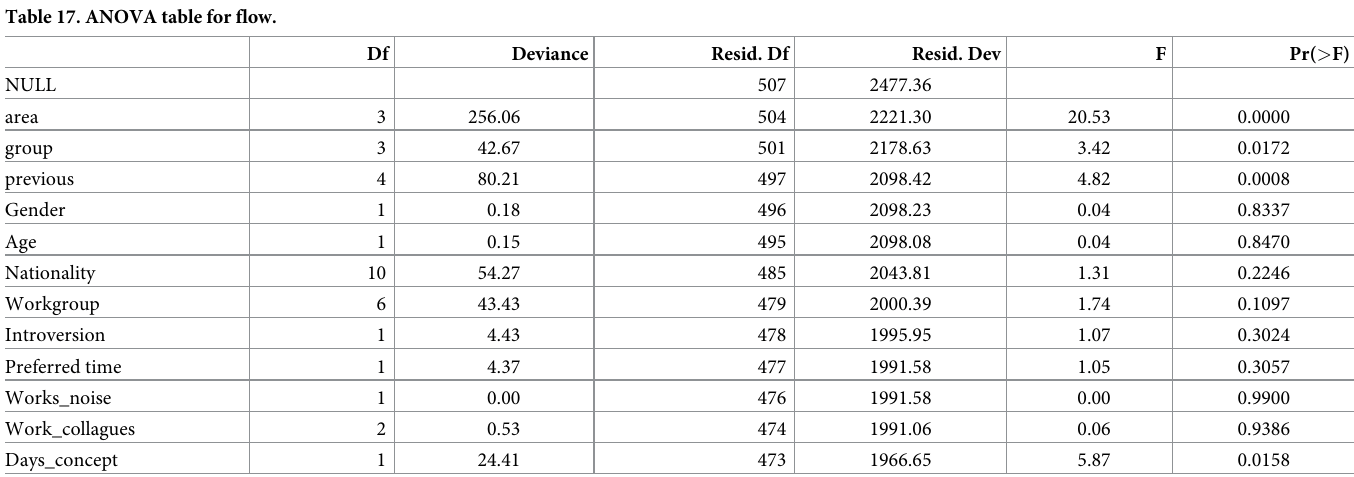
Table 17. ANOVA table for